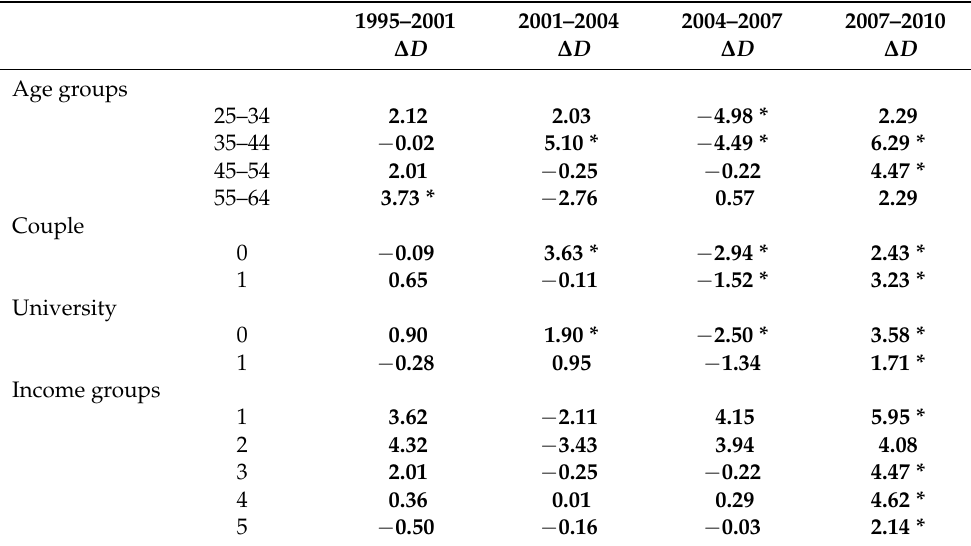
Table 5. The Change in Arrears for different groups: Parametric